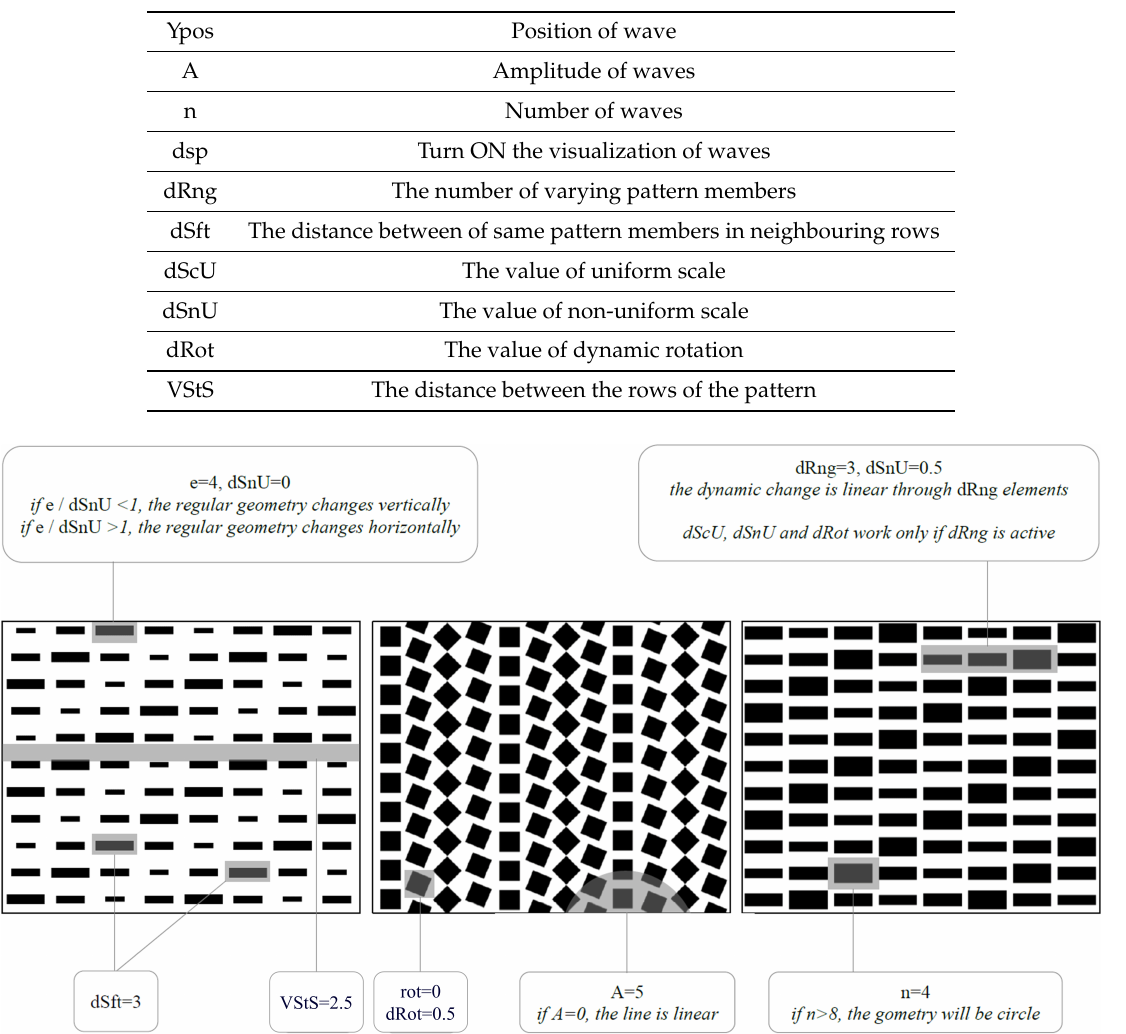
Table 2. Parameters of pattern space functions.